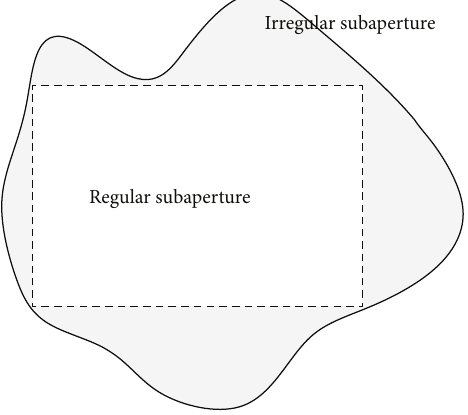
Figure 1: Layout of an arbitrarily shaped